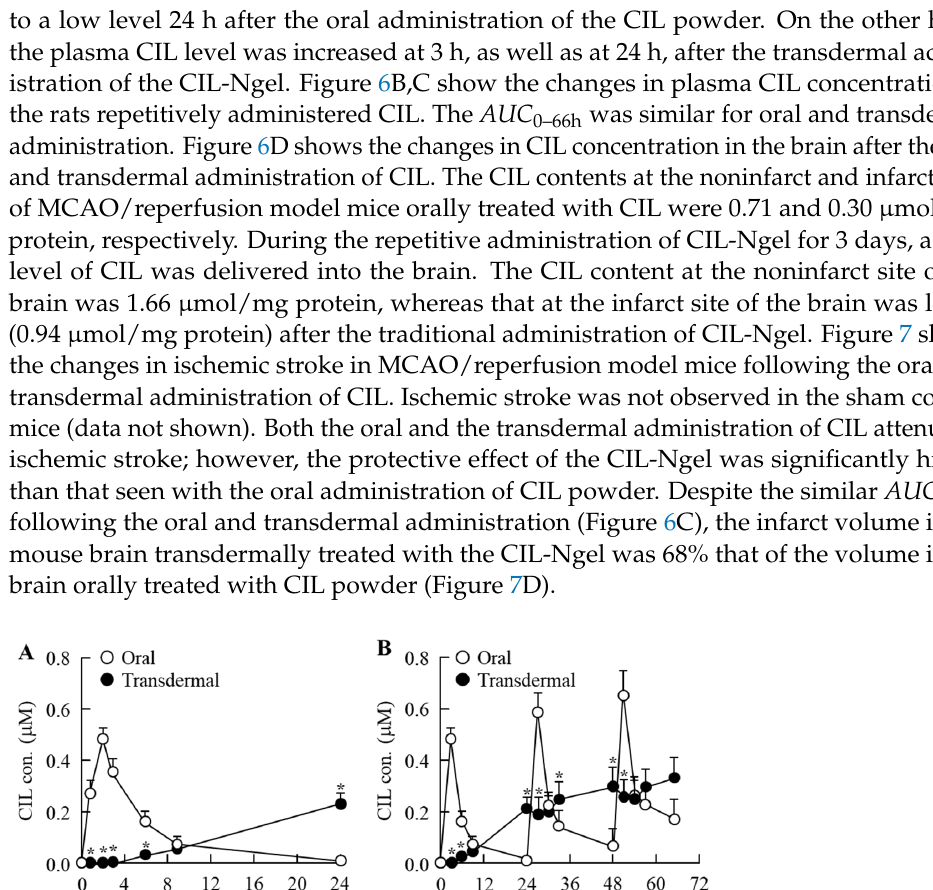
Figure 5. Relationships between energy-dependent endocytosis and transdermal penetration of the CIL-Ngel. ( A ) Transdermal penetration of CIL in the CIL-Mgel and CIL-Ngel under the normal con- dition (37 °C). ( B ) Transdermal penetration of CIL in the CIL-Mgel and CIL-Ngel under the cold condition (4 °C). ( C ) Area under the penetrated CIL concentration–time curves ( AUC 0–24h ) of the CIL-